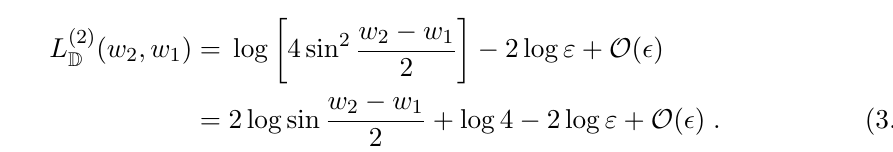
Figure 4 . Examples of disconnected holographic Steiner trees obtained from the Steiner tree G N by a maximal number of inner edge cuts using (2.14). The resulting graphs are ideal Steiner Figure 11 . Disconnected Steiner trees.